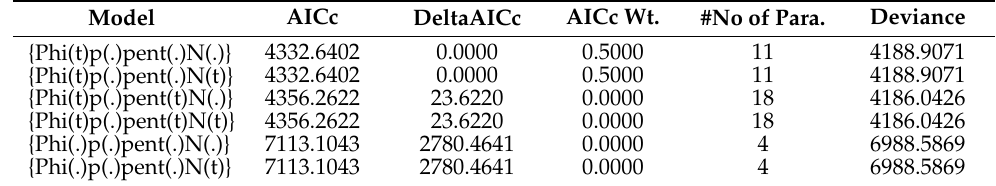
Table 2. Models of survival and population size for female Northern Map turtles using the POPAN function in Program MARK. Models with the lowest AICc values and highest AICc weights were selected as the best-supported models. Parameters (Para) followed by (t) denote time varying estimates, whereas parameters followed by (.) denote time constant estimates. Model Likelihood was 1.000 for the first two models and 0.0000 for the remaining four models. Model AICc DeltaAICc AICc Wt. #No of Para. Deviance {Phi(t)p(.)pent(.)N(.)} 4332.6402 0.0000 0.5000 11 4188.9071 {Phi(t)p(.)pent(.)N(t)} 4332.6402 0.0000 0.5000 11 4188.9071 {Phi(t)p(.)pent(t)N(.)} 4356.2622 23.6220 0.0000 4186.0426 {Phi(t)p(.)pent(t)N(t)} 4356.2622 4186.0426 {Phi(.)p(.)pent(.)N(.)} 7113.1043 2780.4641 6988.5869 {Phi(.)p(.)pent(.)N(t)}